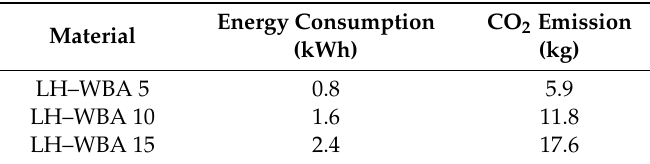
Table 14. Savings in energy consumption and CO 2 emission by the use of WBA in lime blends (per ton of LH–WBA